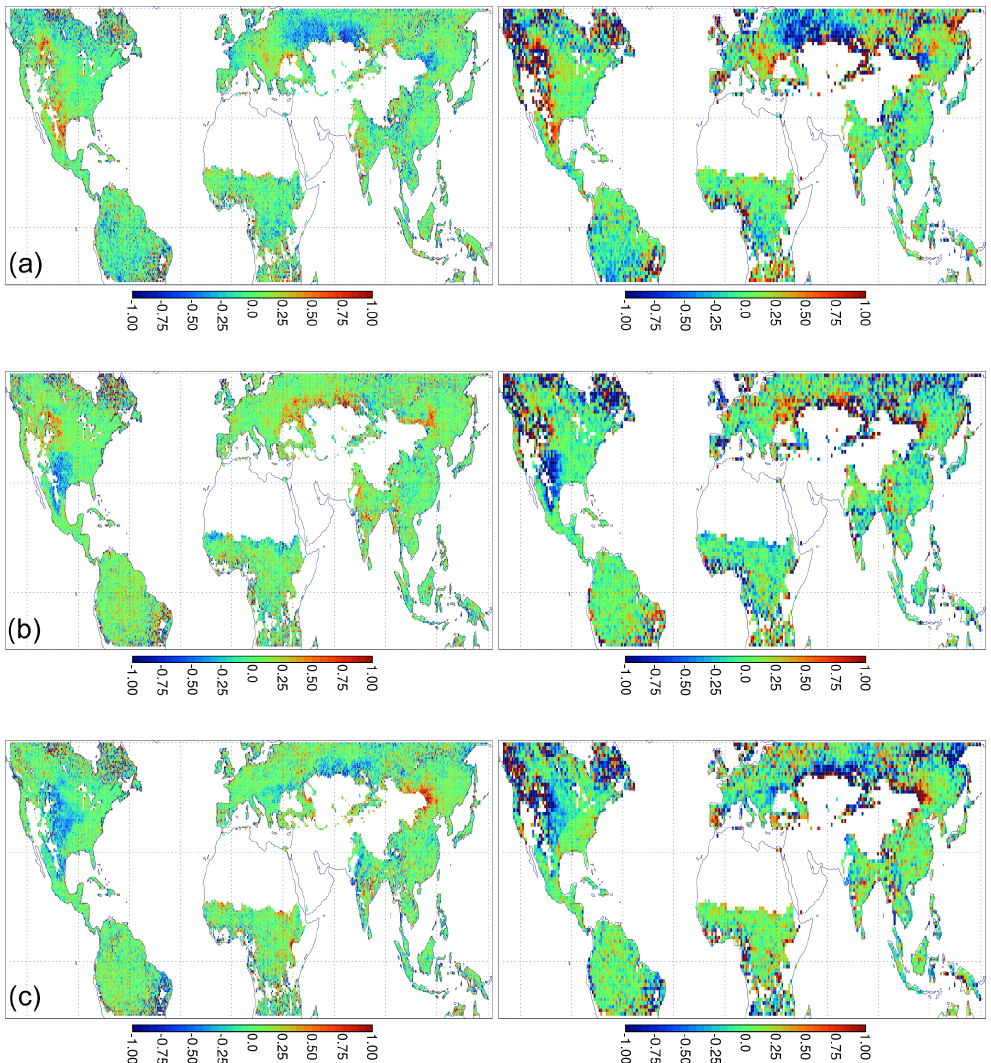
Figure 12. Global SIF anomaly maps (in terms of fractional differences from monthly climatological values computed as averages over the years 2007–2014) for August 2010, 2011, and 2012 (top to bottom) for GOME-2 far-red (left) and red (right) retrievals. (a) SIF anomalies (monthly mean subtracted from observed value at each grid box and then divided by the mean value to provide an anomaly in terms of fractional amount of a climatological value) for August 2010 for far-red (left) and red (right) GOME2 SIF retrievals. (b) Similar to (a) but for August 2011. (c) Similar to (b) but for August